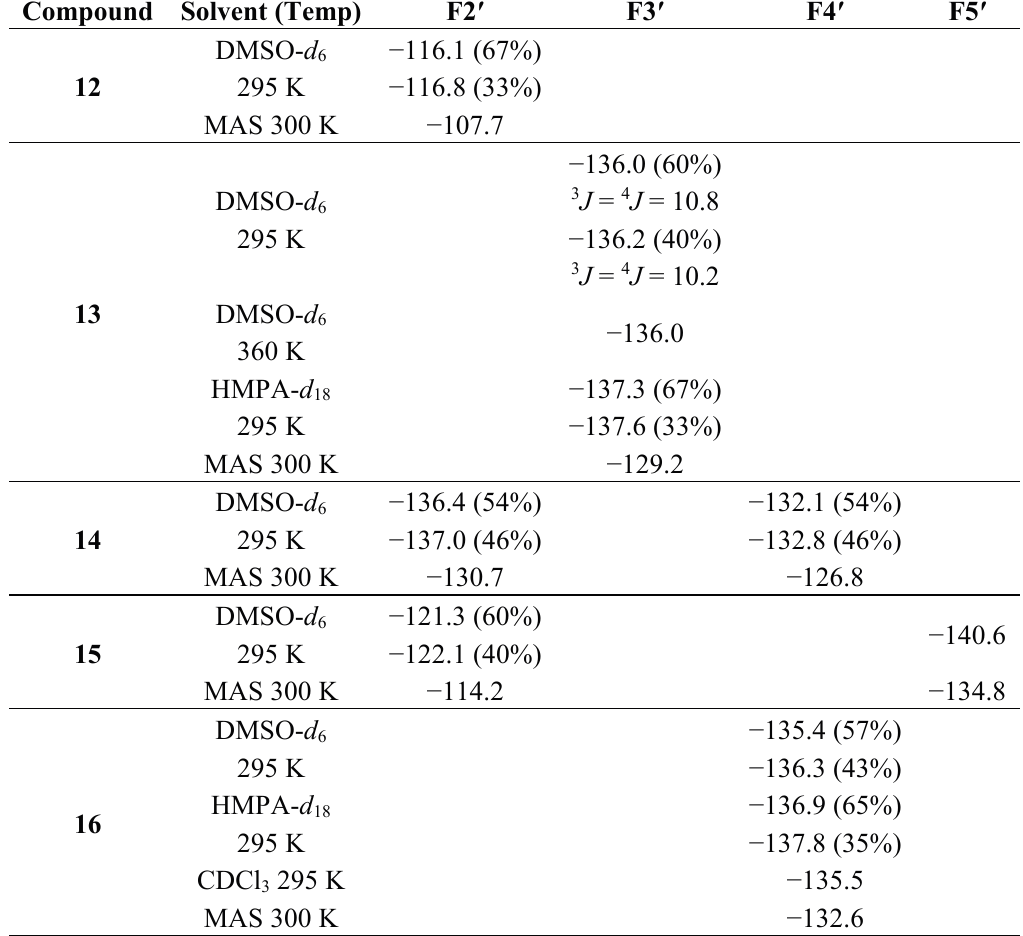
Table 1. 19 F-NMR in solution and solid state of pyrazole derivatives (chemical shifts δ in ppm, J coupling constants in Hz).